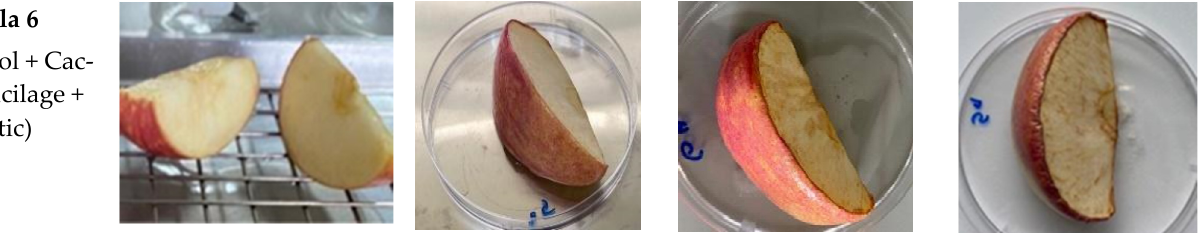
Figure 5. The appearance of fresh cut apple slices dipped in edible coating compared to the control (uncoated) after refrigeration at 4 ° C on days 0, 2, 5 and 7. In this study, the weight loss of fresh-cut apples with and without edible coatings was also evaluated (Figure 6). Significant weight loss occurred in uncoated fresh-cut apples (control). Constant losses in weight were observed in all coated samples up to day 7, except for samples that were coated with the bioactive edible formula 5, which exhibited no significant reduction in weight at the end of 7 days of storage. Bioactive edible formula 6 also exhibited a protection against weight loss, though not to the same degree as formula 5. Previous studies reported weight loss of stored product was lower when yeasts of the species Cryptococcus laurentii were added in the coatings, suggesting that the addition of microorganisms can influence this aspect of food preservation [43]. Our result also suggested the lower WVP of formula 5, compared to formula 6 (Table 3), may help to counter water loss from the product. Reduction in product weight loss and darkening, as well as maintaining the freshness and extending the shelf life of fresh-cut products, are all important factors for the commercialization of edible films. Our results indicated bioactive edible formula 5 was the best suited to meet these parameters.